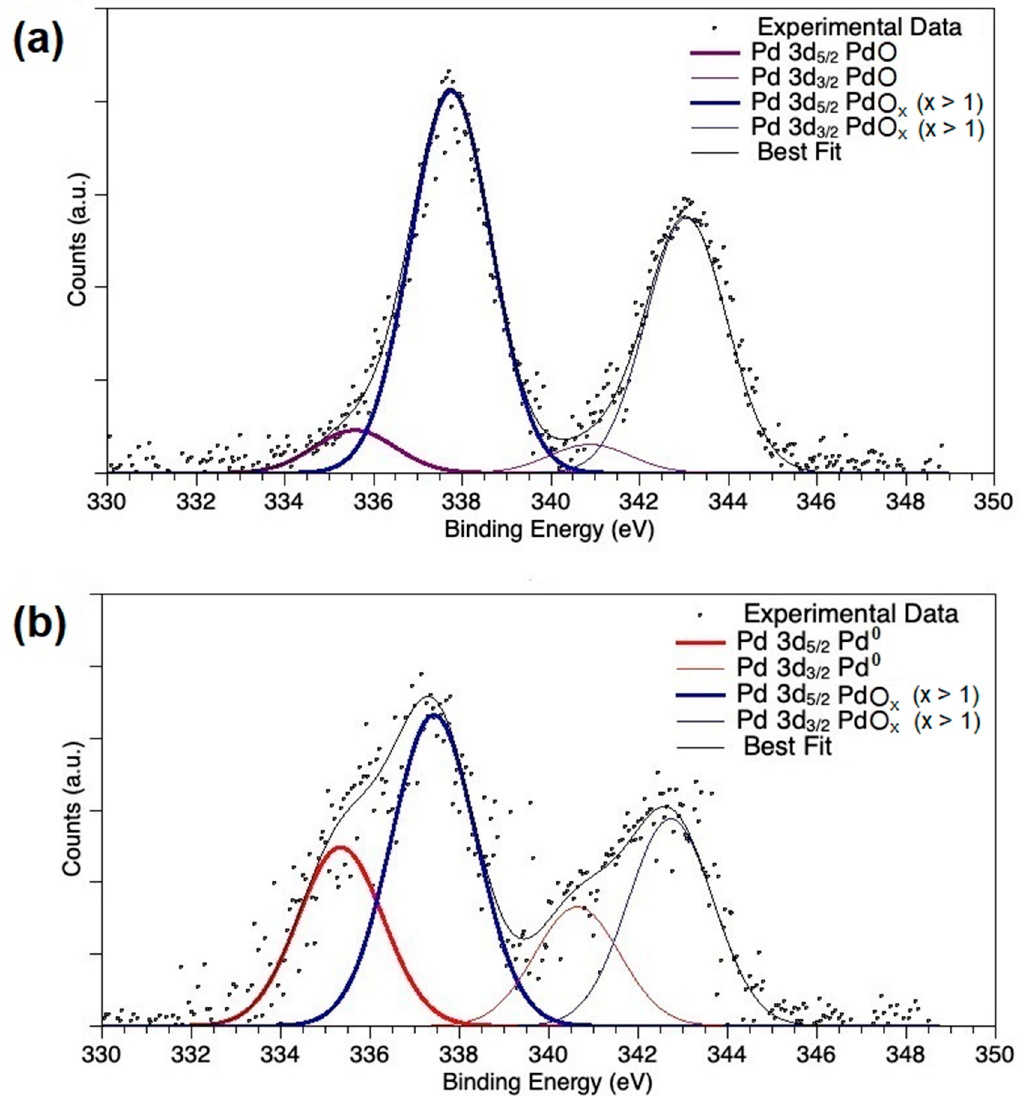
/ CeO x 2 -NR and ( b ) PdO x